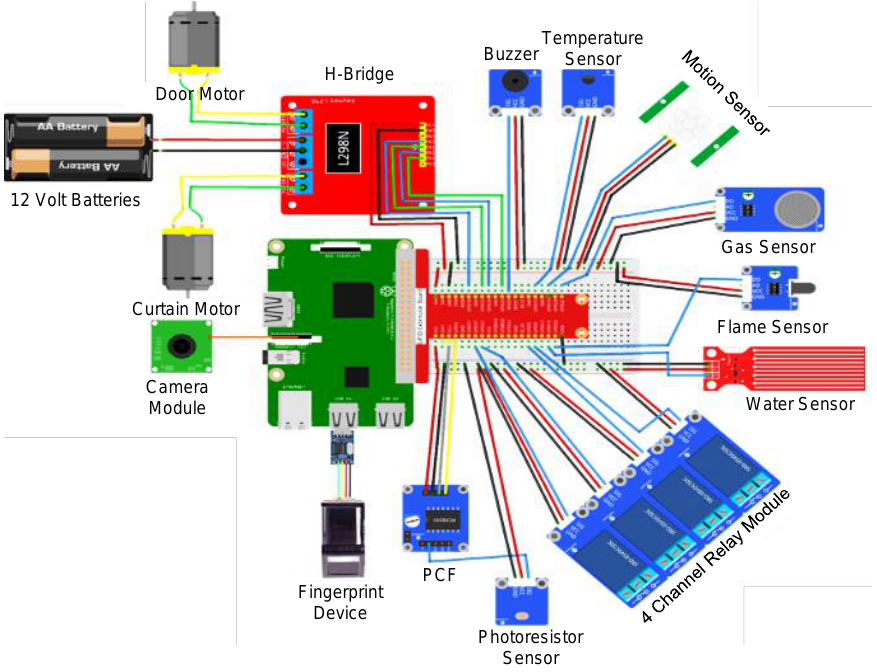
Figure 5. Connectivity of each module with RPI. The wires in red indicate voltage connectivity, black ones show the ground connectivity, and the wires in blue indicate signal line or data transmission line.